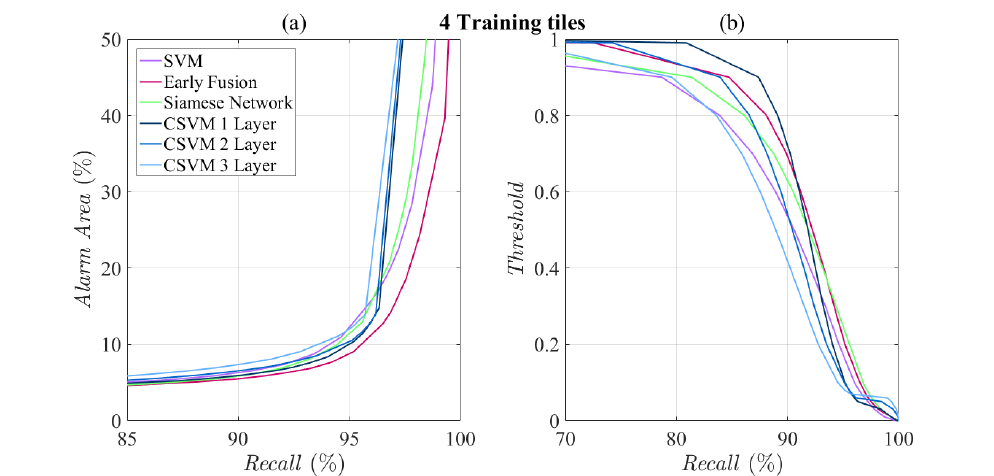
Figure 24. ( a ) Recall vs. Alarm Area (deforested area) for Cerrado biome using four training tiles. ( b ) The recall values are obtained by threshold